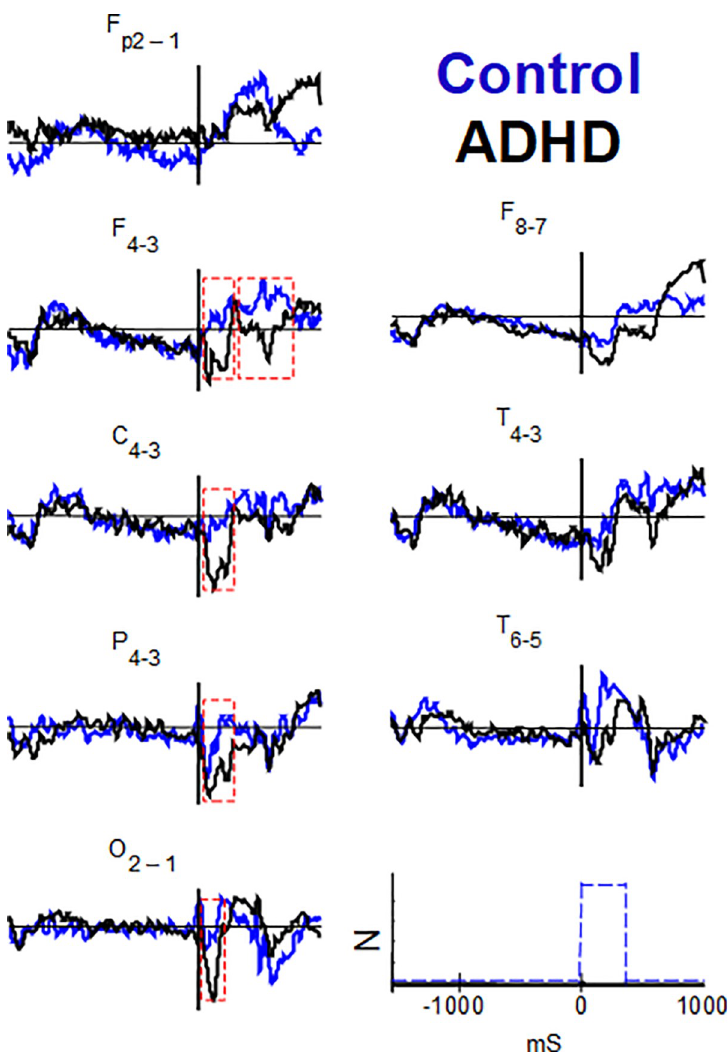
Fig 6. Interhemispheric differences (asymmetries) in the mean values of all conditions in ADHD and control groups. Control and ADHD groups in blue and red waves, respectively. The asymmetries of interest are delimited by dashed red boxes. Amplitudes are normalized (positive values above abscissae). See Fig 2, for channel labeling. showing a higher right-side amplitude prevalence of negative signal in the central region in ADHD compared to the controls (Fig 6 and Fig 7A). We also observed a significant difference between groups in O2-O1, in the window between 40 and 200 ms, emphasizing that the ADHD group expresses higher mean negativity to the right than the control group (Fig 6 and Fig 7B): AllCd (-1.88 ± 2.09 μ V and -0.22 ± 2.07 μ V, respectively; p = 0.026), NoCue (-1.98 ± 2.32 μ V and -0.24 ± 1.79 μ V, p = 0.029), NtCue (-1.92 ± 2.36 μ V and -0.40 ± 2.00 μ V,